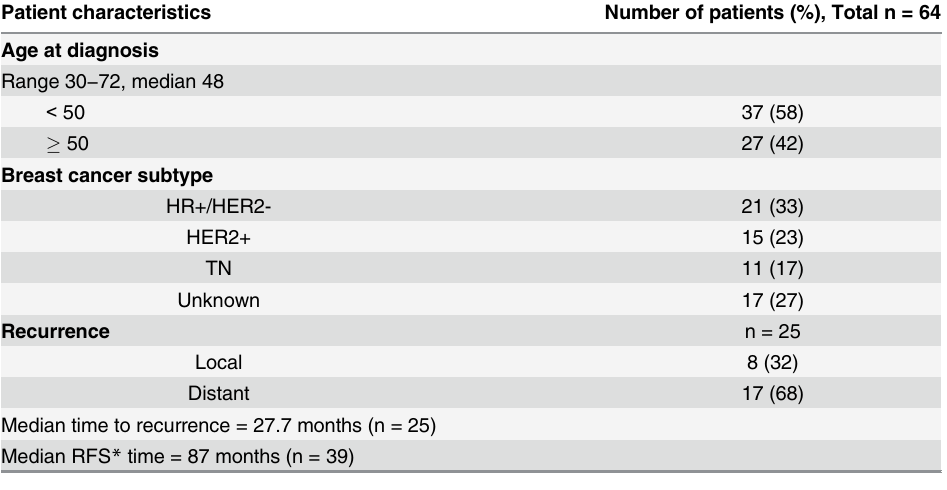
Table 1. Demographic and patient